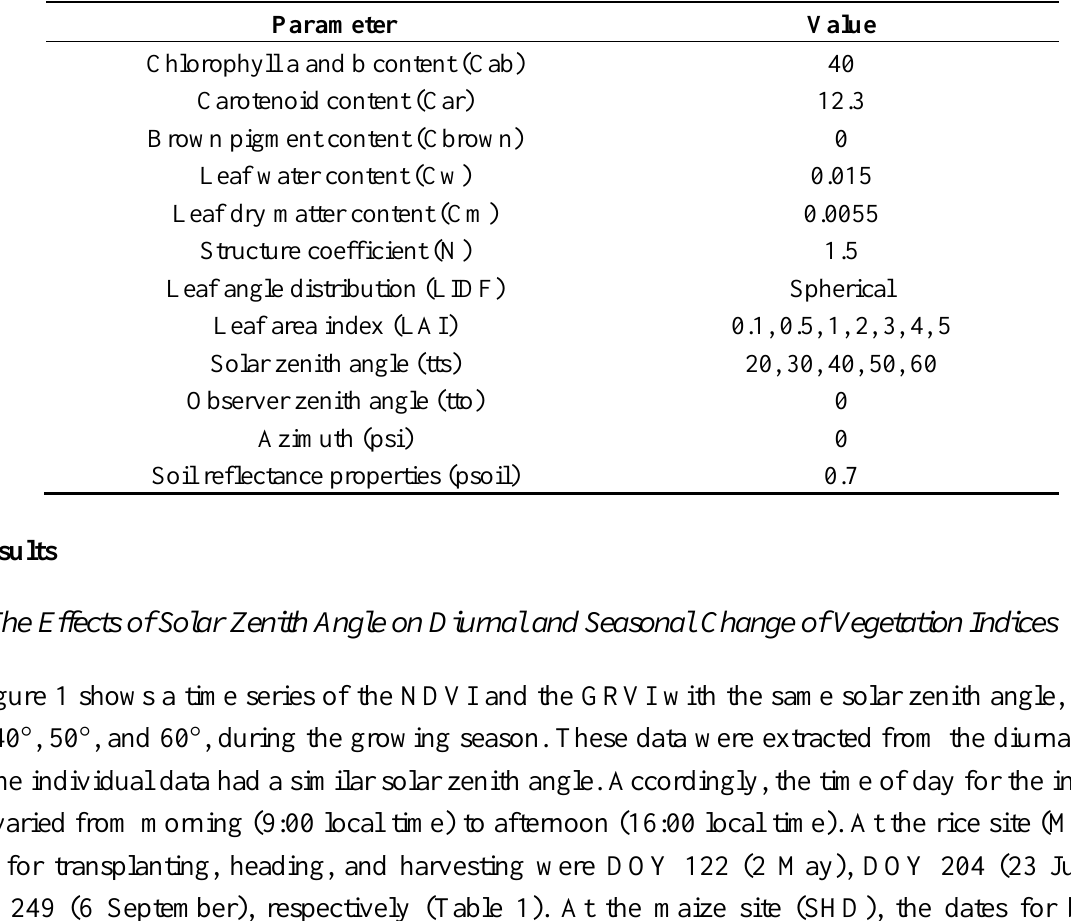
Table 2. List of input parameters for the PROSAIL